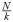
Changes in the number of tests and steps given different estimated positive rates for the adaptive methods.The figure shows the number of tests (y-axis) and the number of steps (marker size) required to recover all positive samples (x-axis) in simulations with N = 384 samples using each of the adaptive methods. For each method, except for Binary Splitting by Halving, the pooling scheme was optimized around the expected number of positive samples (marker color) provided to each simulation. Each point represents a single simulation and the lines are the average number of tests for a given number of expected positives. The black dashed line in the S-Stage, 3-Stage, and Binary Splitting by Halving figures represents the upper bound of the number of tests (assuming that the number of positive samples is estimated correctly, where applicable). For the Generalized Binary Splitting figure, the number of tests approaches the lower bound (black dashed line) when Nk is large.